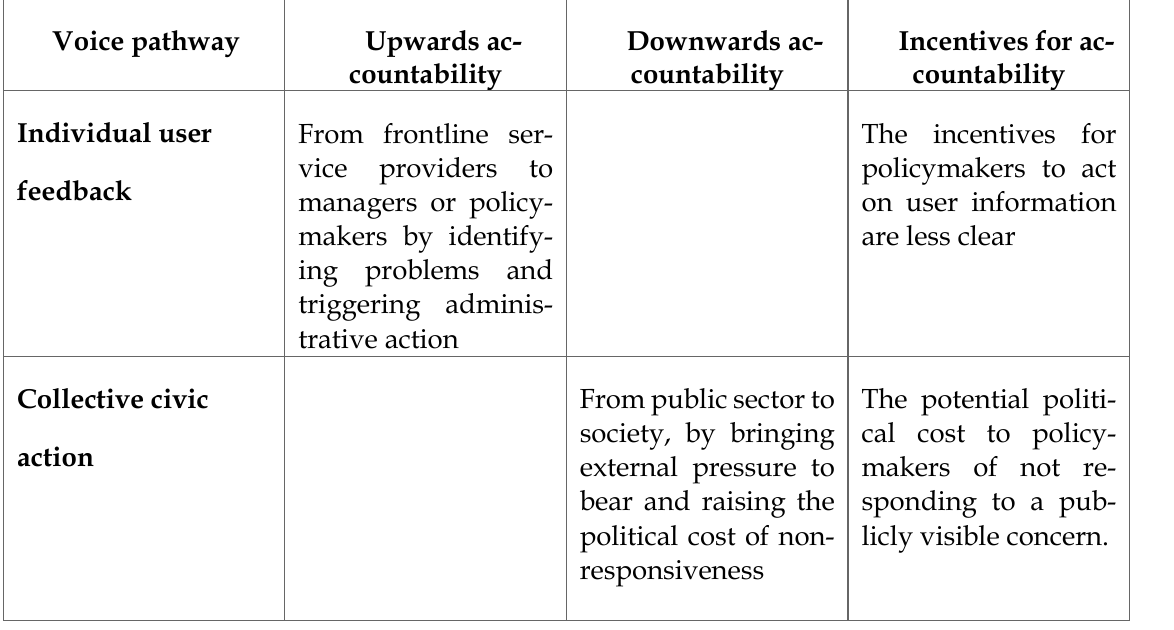
Table 2: Primary Causal Mechanisms for Accountability Primary Causal Mechanism for Accountability Voice pathway Upwards ac- Downwards ac- Incentives for ac- countability countability countability From frontline ser- The incentives for Individual user vice providers to policymakers to act feedback managers or policy- on user information makers by identify- are less clear ing problems and triggering adminis- trative action From public sector to The potential politi- Collective civic cal cost to policy- society, by bringing action makers of not re- external pressure to sponding to a pub- bear and raising the licly visible political cost of non- responsiveness